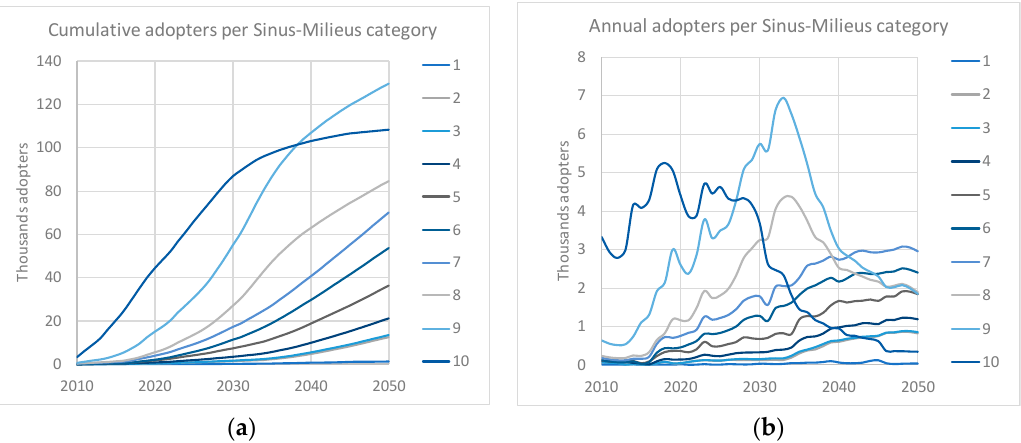
Figure 7. Cumulative adopters ( a ) and annual adopters ( b ) per Sinus-Milieus ® category; for a mapping to the IDs reported in the figure to the Sinus-Milieus ® category, please see Table 1 .